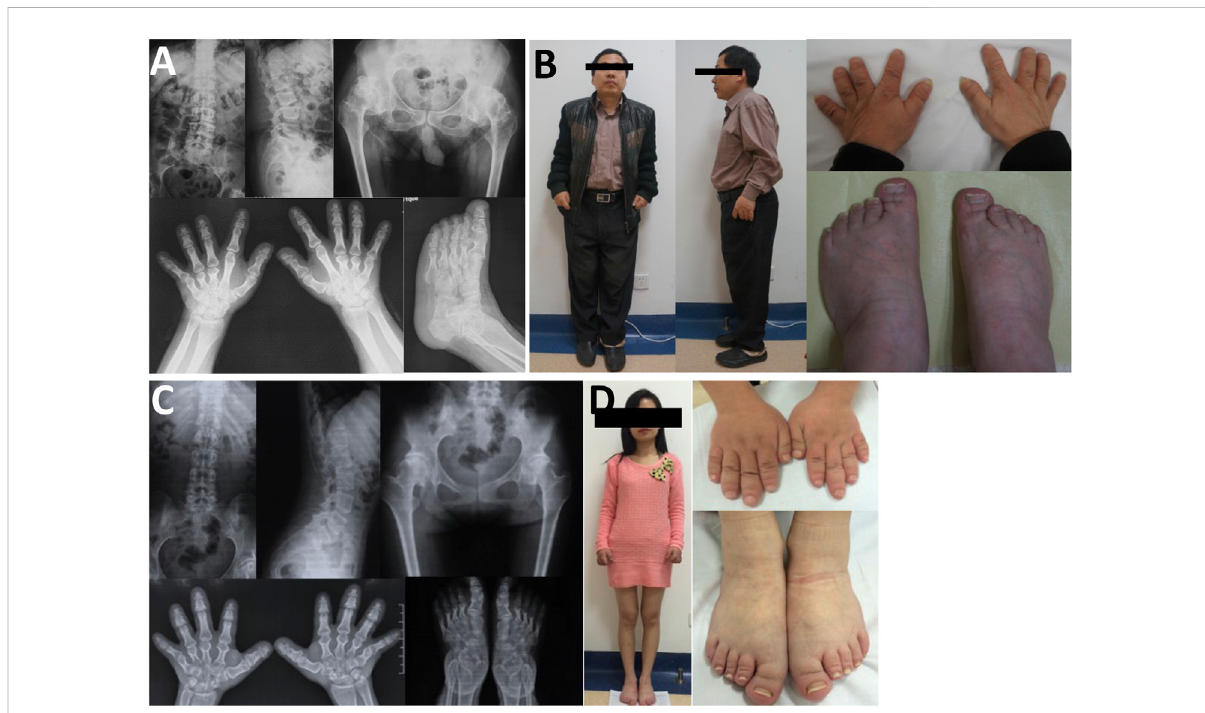
FIGURE 6 Photographsandradiographsofthefamily7. (A,B) Radiographsofthespine,pelvis,hands,andfeet (A) andphotographs (B) ofproband7( Ⅱ -2)in family 7. (A) Mild fl attening and irregular shape of the vertebral bodies and 4 – 5 lumbar spondylolisthesis were shown in the spine. Flattening of the acetabulum, hip subluxation, femoral head necrosis, and shortening of the femoral neck were revealed in the pelvis. Widened epiphysis and joint cavitystenosisweredisplayedinthehandsandfeet. (B) Shortstaturewithshortlimbwasvisibleinthefullbody. Thickandshort fi ngersandtoes were shown in hands and feet. (C,D) Radiographs of the spine, pelvis, hands, and feet (C) and photographs (D) of patient ( Ⅲ -1) in family 7. (C) Mild fl attening and irregular shape of the vertebral bodies were displayed in the spine. The pelvis was normal. Widened epiphysis and joint cavity stenosis were displayed in the hands and feet. (D) Thick and short fi ngers and toes were shown in hands and